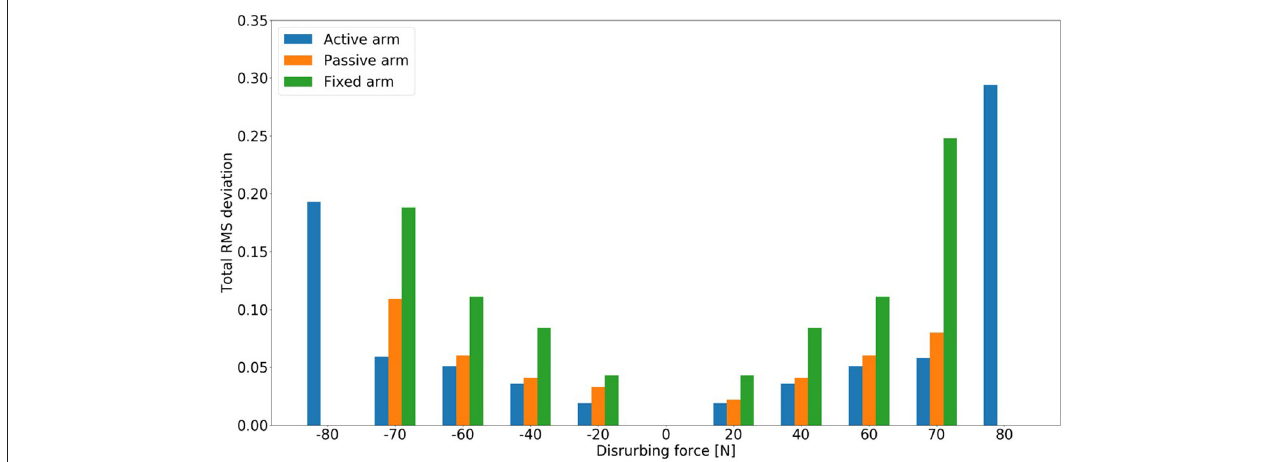
FIGURE 7 | Evolution of the total RMS deviation of the model for three different arm states (active arm, passive arm, and fixed arm) for different disturbing forces: (1) Push backward: − 20 [ N ], − 40 [ N ], − 60 [ N ], − 70 [ N ], and − 80 [ N ]; (2) No force: 0 [ N ]; (3) Push forward: 20 [ N ], 40 [ N ], 60 [ N ], 70 [ N ], and 80 [ N ]. There was no solution for the cases of passive and fixed arms under the disturbing forces − 80 [ N ] and 80 [ N ].